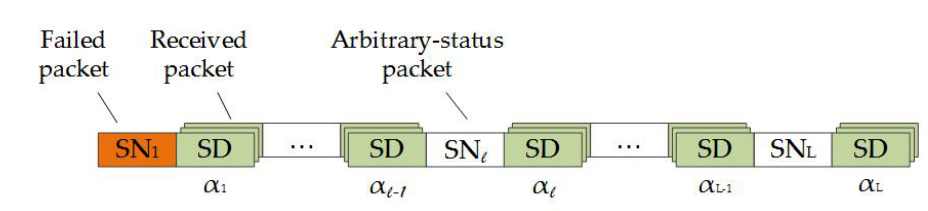
Figure 6. The status of the reordering buffer after the transmission in Category 1. SD represents the successfully delivered packets in previous